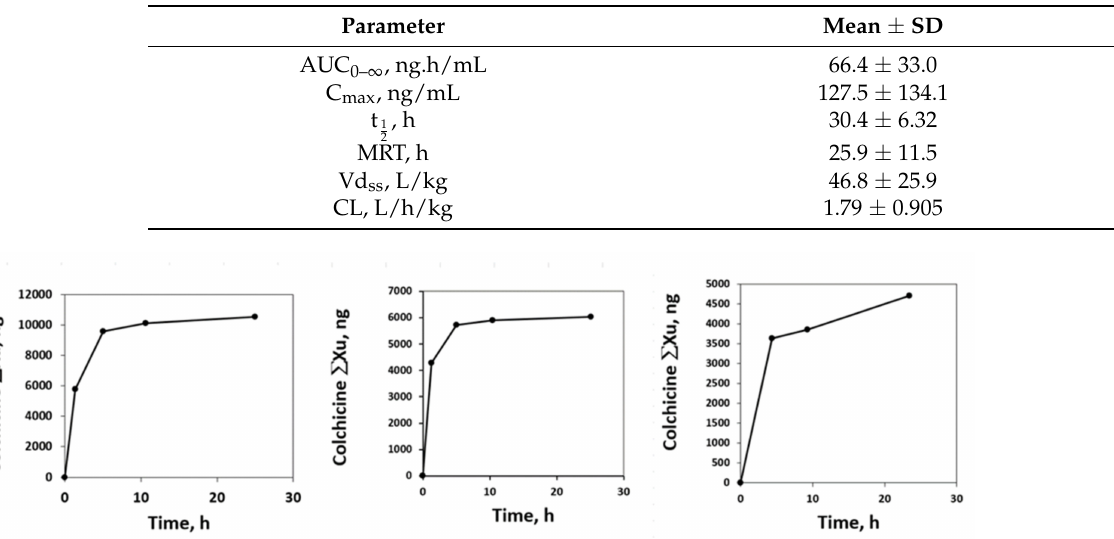
Figure 7. Cumulative urinary excretion vs. time plots for three male Sprague-Dawley rats after intravenous dose of 0.1 mg/kg